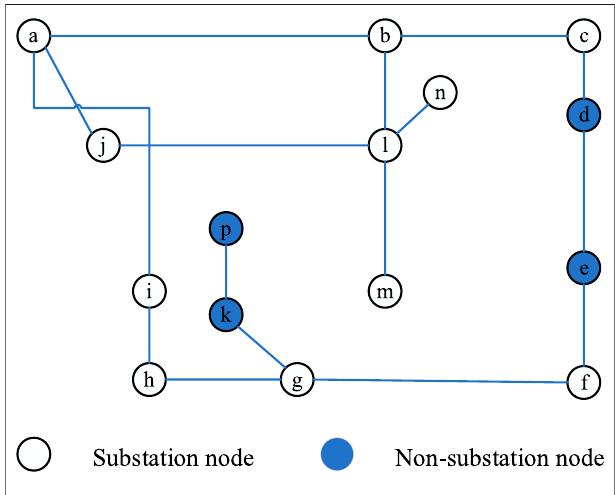
FIGURE 5 | Topology of the power grid.